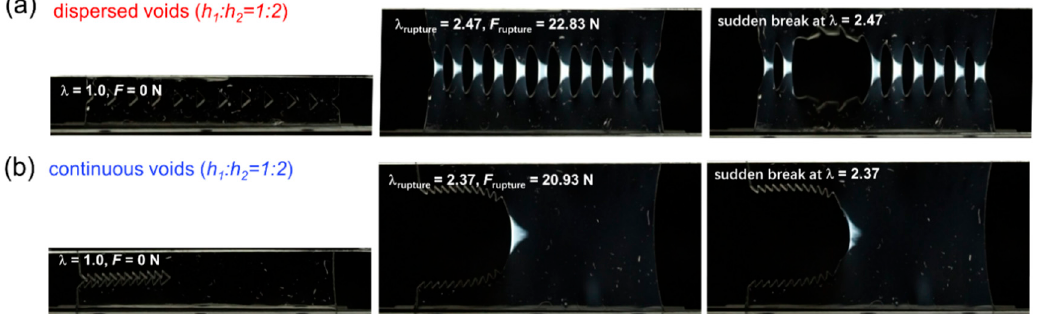
Figure 6. Birefringence observation during fracture of D-cut and C-cut gels at spacing ratio h 1 : h 2 of 1:2. ( a , b ) The representative snapshots of crack evolution in DN hydrogel samples under different structural models containing dispersed cuts ( a , D-cut gel) and continuous cuts ( b , C-cut gel) at spacing ratio h 1 : h 2 of 1:2.